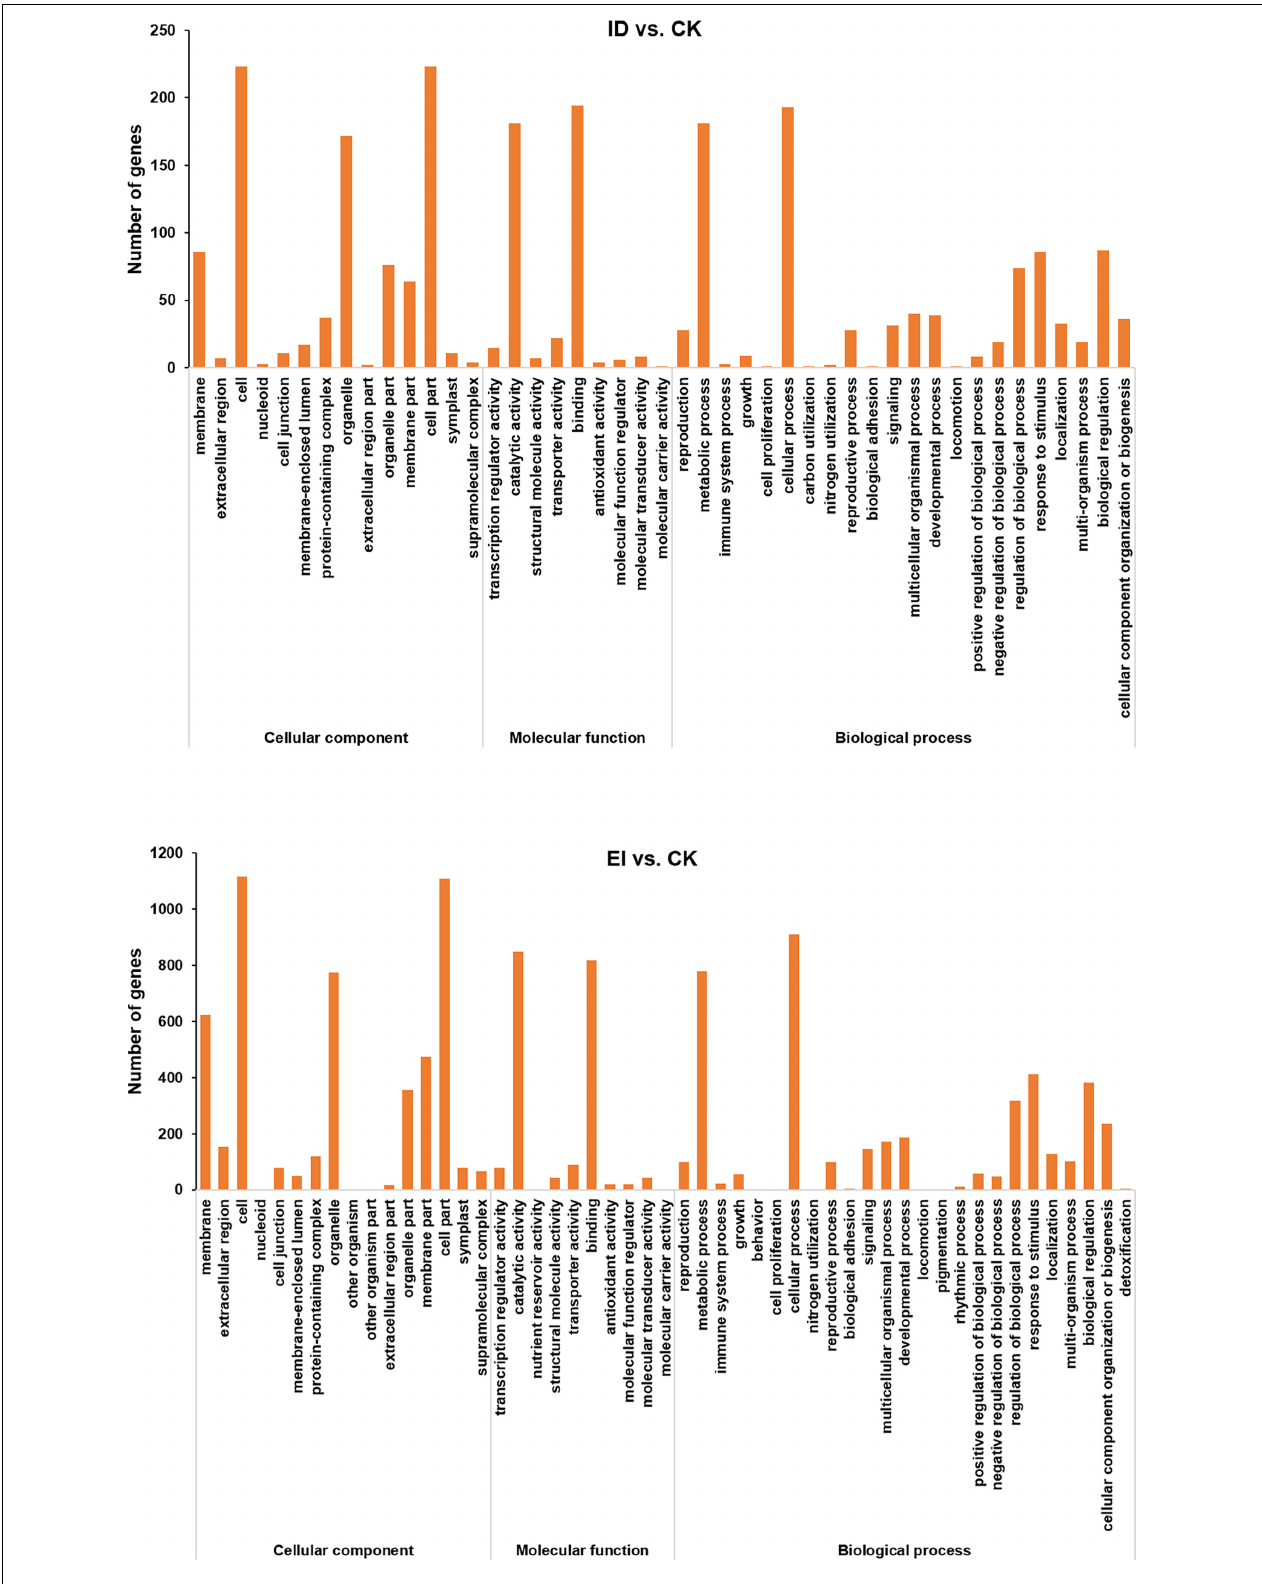
FIGURE 4 | Summary of GO (gene ontology) categories of DEGs. The numerals beside the histogram indicate the number of DEGs.